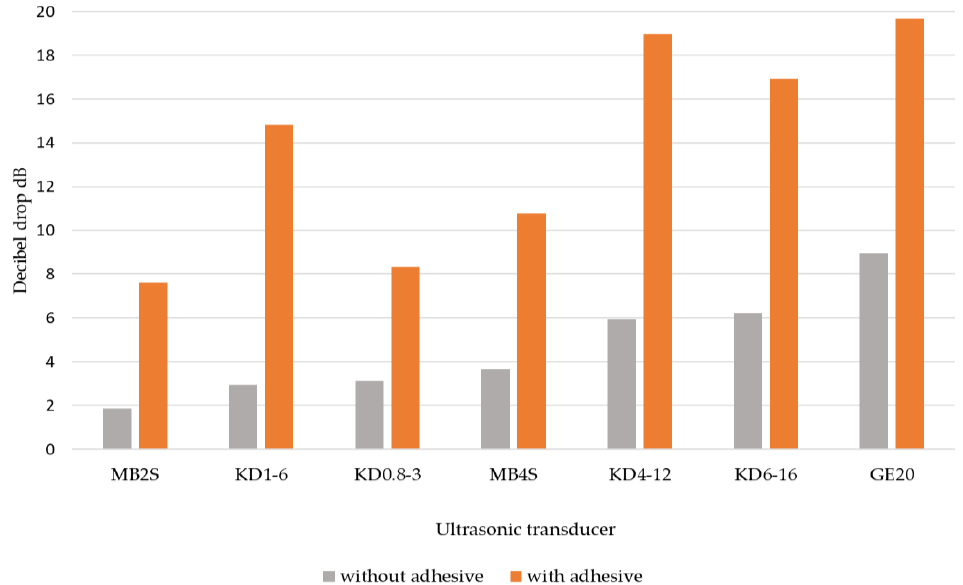
Figure 8. Decibel drop for samples with and without adhesive of Ti6Al4V-AM material.